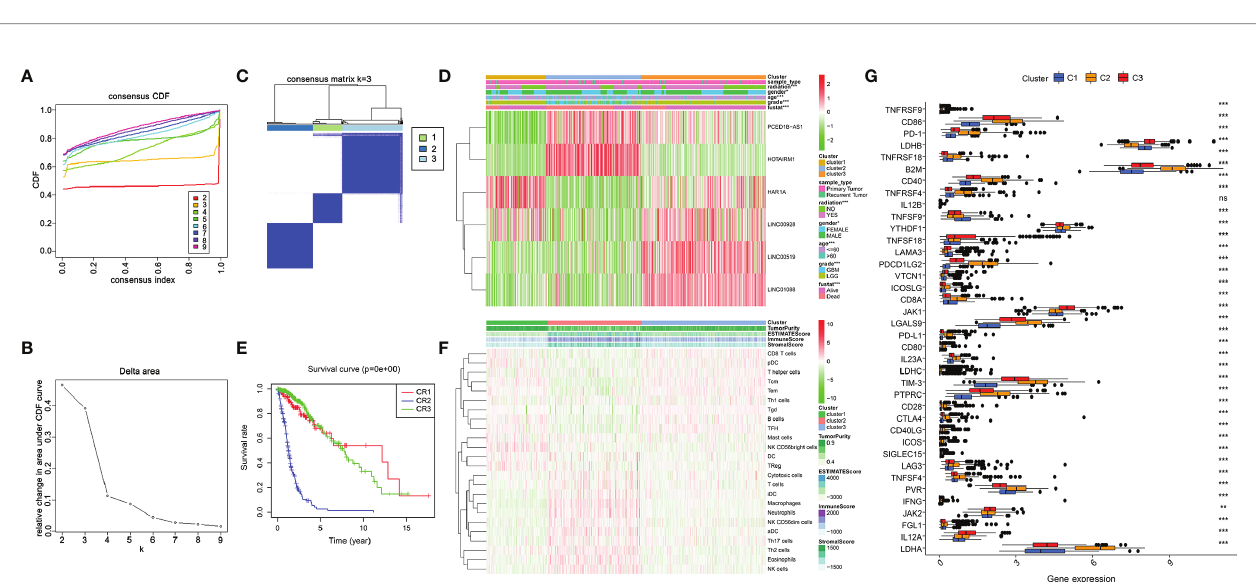
FIGURE 4 | Relationship between risk model and clinicopathological features and prognostic value in CGGA cohort. (A) Heatmap showed the expression level of 6 ER stress-related lncRNAs and the distribution of clinicopathological features in risk subgroups. (B) K-M survival analysis based on the 6 ER stress-related lncRNAs between two risk groups in testing cohort. (C) ROC curve evaluates the predictive ef fi ciency of the risk model in the testing database. (D) Expression pro fi les of six ER stress-related lncRNAs in risk subsets in glioma patients. (E, F) Distribution of risk score, survival time, and survival status of glioma patients in testing set.